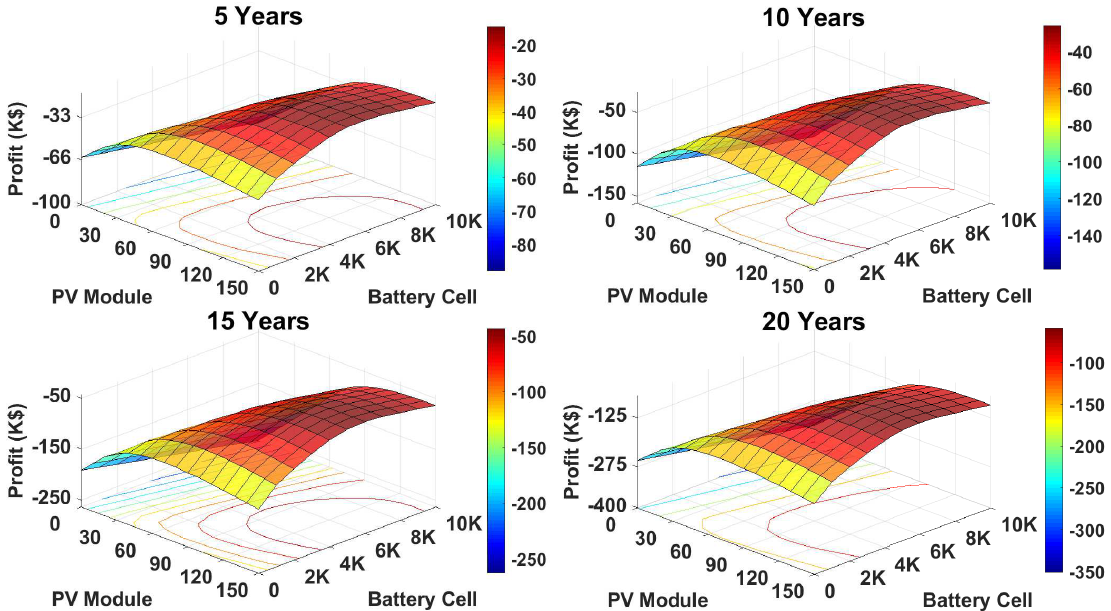
Figure 11. Profit in different years with various configurations for case without wind turbine in EES.